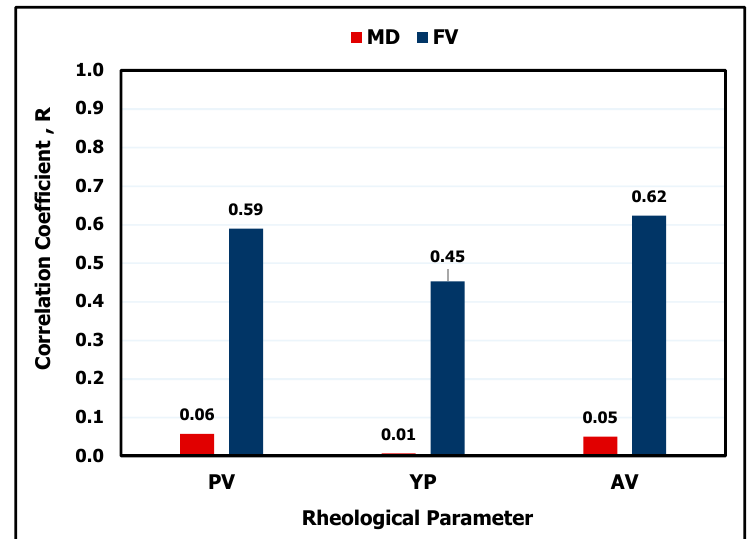
Figure 2. Correlation coefficient (R) between the inputs: mud density (MD) and Marsh funnel viscosity (FV) and the outputs: yield point (Y P ), plastic viscosity (PV) and apparent viscosity (AV).